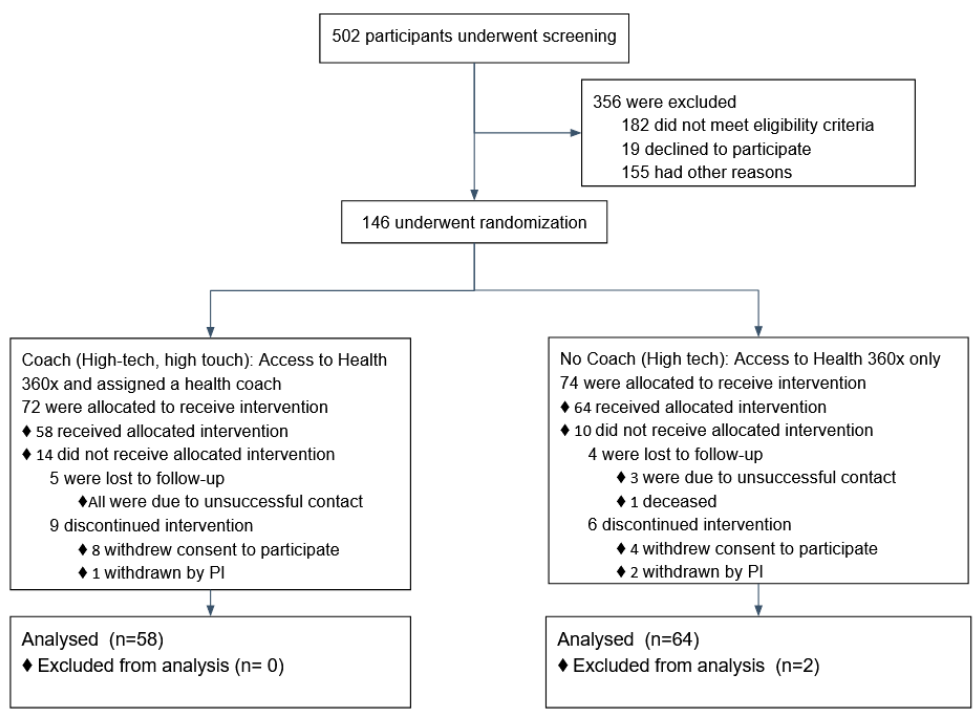
Figure 1. Flowchart of screening, randomization, and follow up.